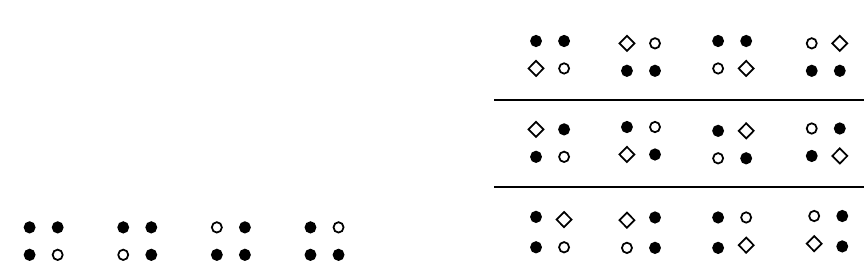
Figure 4 . The left (cid:12)gure shows that there is a single Z 2 (cid:2) Z 2 orbit in subsectors t (cid:10) 3 v ; tv (cid:10) 3 ; v (cid:10) 3 s . The right (cid:12)gure shows the three distinct Z 2 (cid:2) Z 2 orbits in the subsector t (cid:10) 2 vs